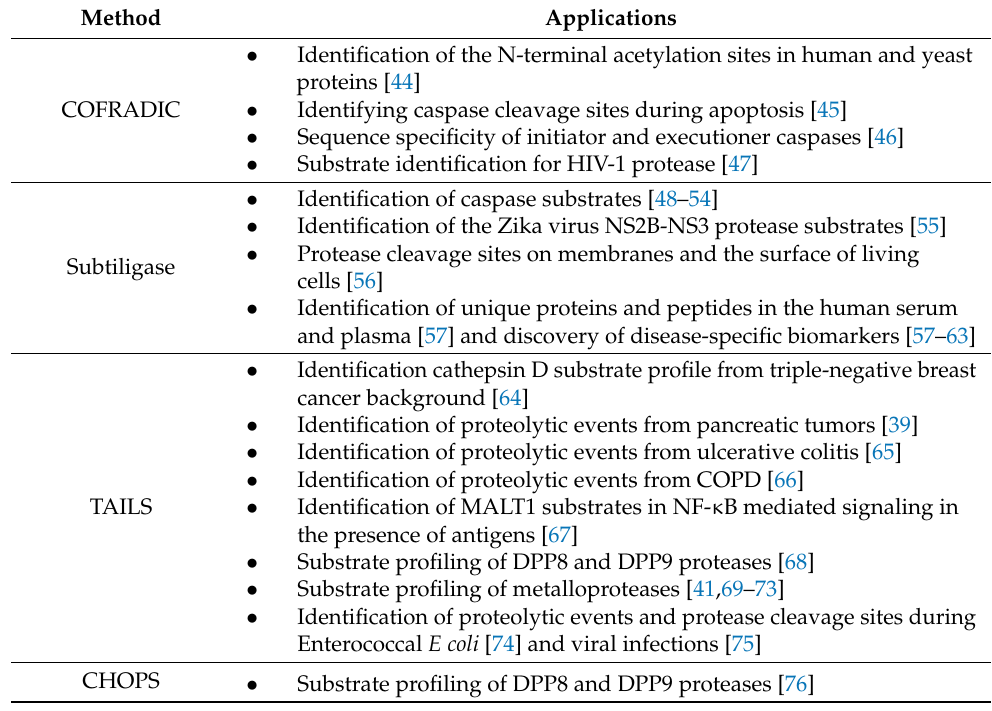
Figure 2. Forward and Reverse approaches of N-terminomics. ( A ) In the forward N-terminomics approach, treated and control samples lysed and subjected N-terminomics workflow followed by LC-MS/MS analysis to identify the global proteolysis. ( B ) In the reverse N-terminomics, samples are lysed, followed by the addition of protease of interest. The treated and control samples are then subjected to LC-MS/MS analysis to identify the physiological substrates and substrate specificity of the protease of interest. Table 1. Applications of N-terminomics methods.